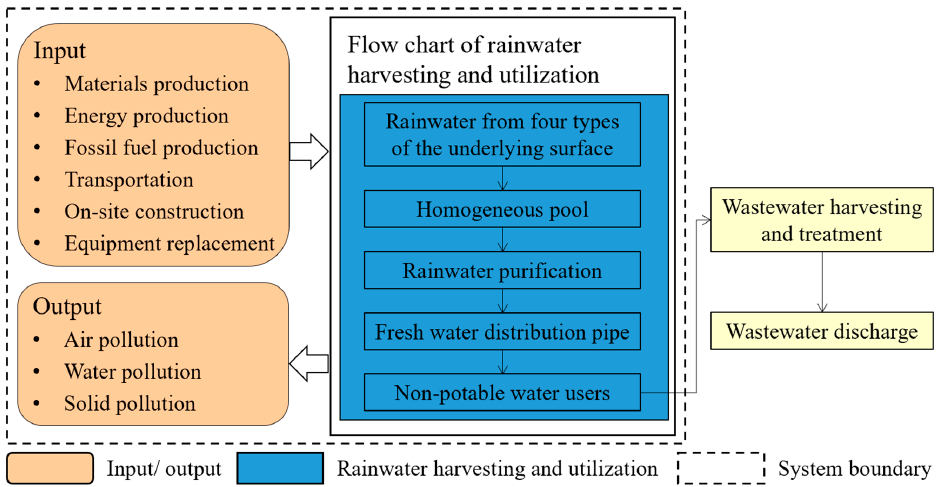
Figure 2. System boundary of rainwater harvesting and utilization for the life cycle assessment study.